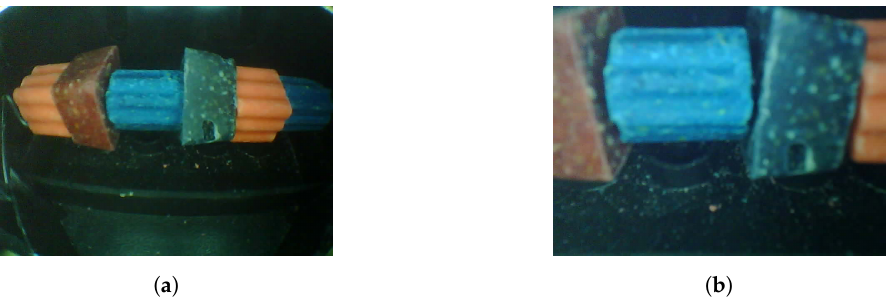
Figure 5. Captured images of the bait rod using a Fisheye lens ( a ), and without the Fisheye lens ( b